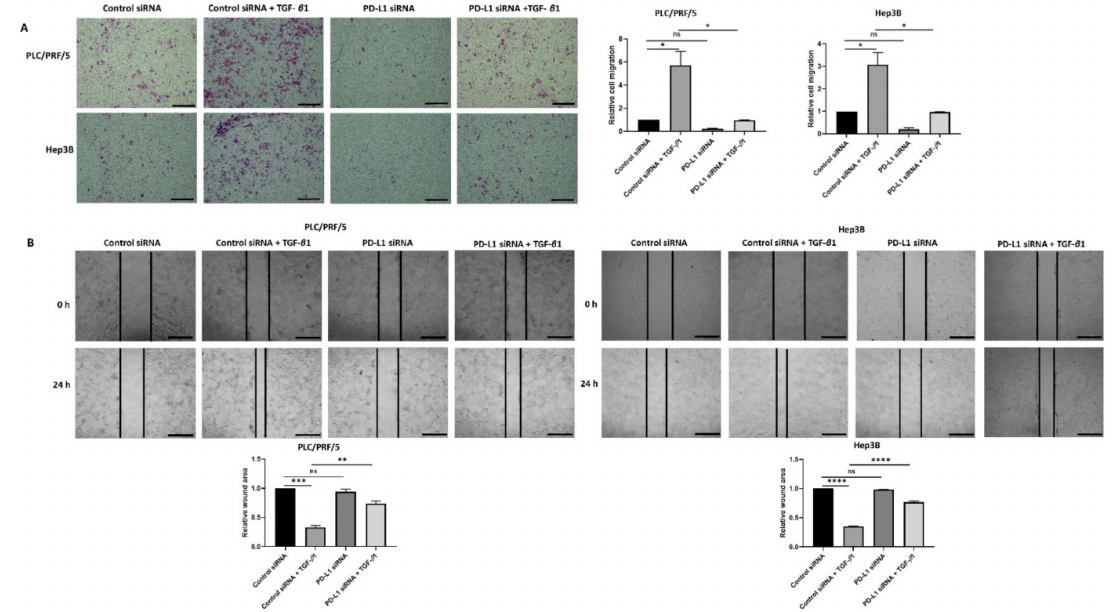
Figure 8. Silencing of PD-L1 reverses migratory ability of TGF- β 1-stimulated HCC cells. ( A ) Transwell migration assay revealed reduced migratory capability of PLC/PRF/5 and Hep3B cells following PD-L1 knockdown despite stimulation with TGF- β 1 (scale bar = 500 µ m). The number of motile cells was determined by measuring the absorbance of Crystal Violet staining. ( B ) Decreased motility of PLC/PRF/5 and Hep3B cells following PD-L1 knockdown despite stimulation with TGF- β 1 was validated by the wound healing assay (scale bar = 500 µ m). The analysis of the wound area after 24 h treatment with siRNA alone or when combined with TGF- β 1 relative to the starting wound area at 0 h ( n = 3, * p < 0.05, ** p < 0.01, *** p < 0.005, **** p <